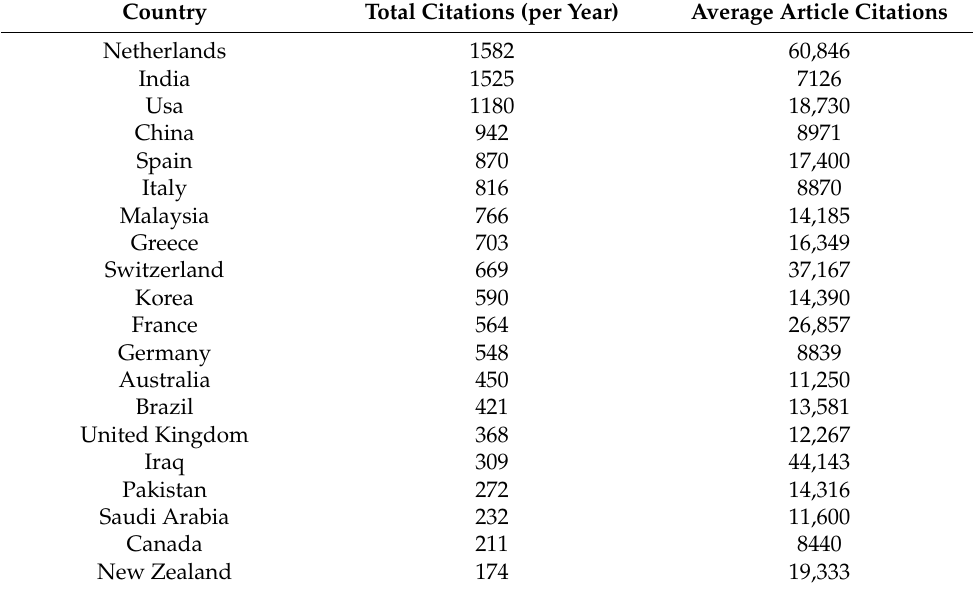
Table 2. Scientific production of the main countries related to the smart and precision farming. Country Total Citations (per